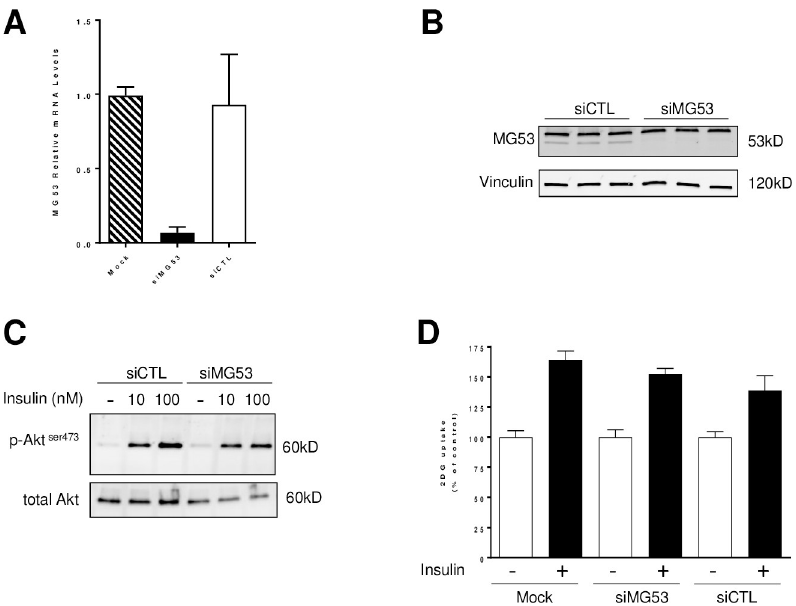
Fig 2. MG53 gene knock-down does not affect insulin signaling in differentiated C2C12 cells. C2C12 cells were transfected with small interfering RNA targeting MG53 or a non-silencing control siRNA (10nM) using Lipofectamine RNAi max. 48h post-transfection, MG53 mRNA (Panel A) and protein levels (Panel B) were assessed by qPCR and western blot analysis, respectively. Vinculin was used as a loading control (Panel B). Insulin response (10 or 100nM for 10 minutes) was assessed by monitoring Akt phosphorylation on Serine 473 (Panel C). Finally, glucose uptake was measured using 2DG-glucose in response to insulin treatment (100nM) (Panel D). Data are expressed as percentage of control (Mock-transfected